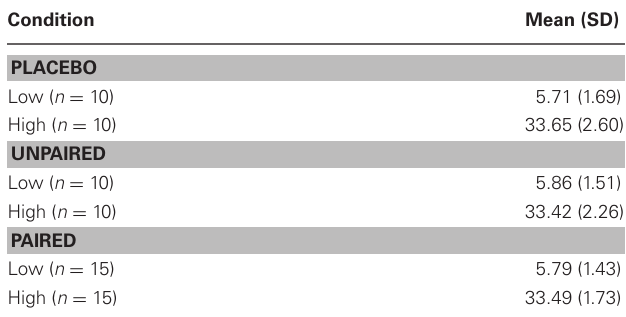
Table 1 | MPQ Extraversion scores for low and high extraversion subgroups in each